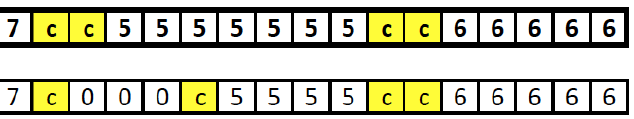
Figure 4. Examples of neighborhood definition